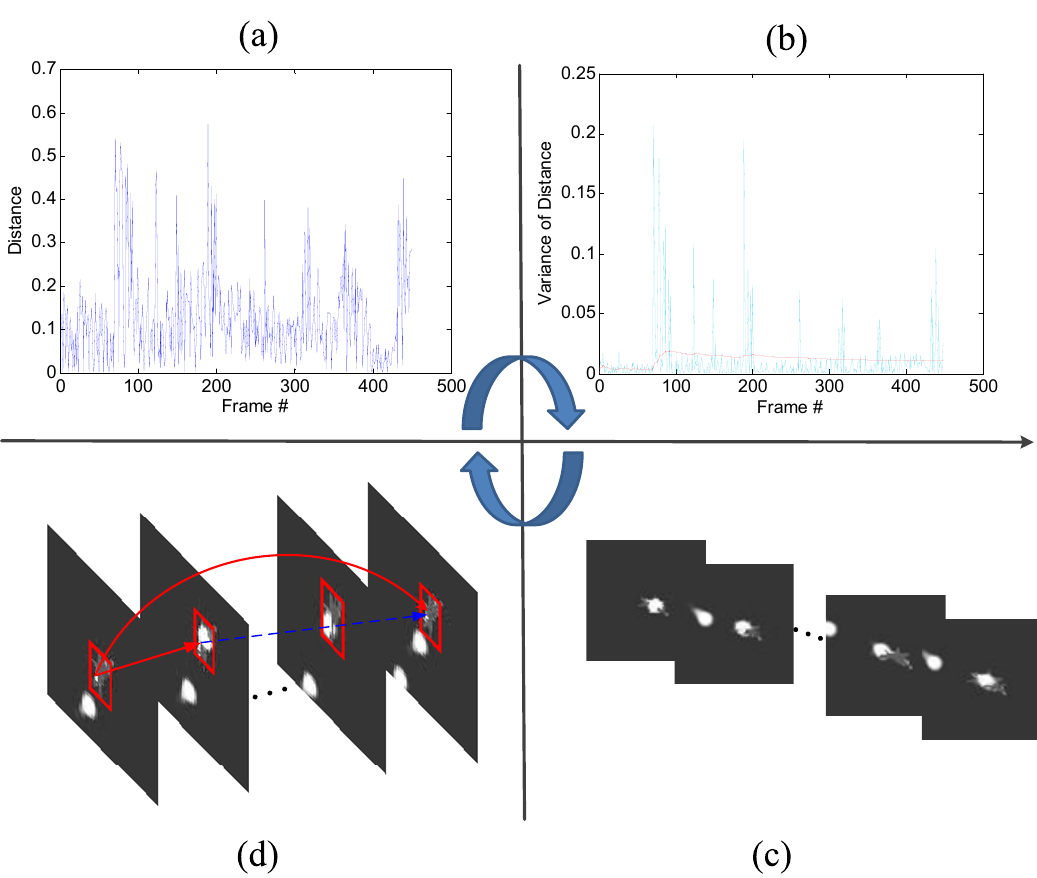
Figure 10. Schematic diagram for occlusion detection. ( a ) distance curve between selected region and target model in the model-matching process; ( b ) red plot represents the statistical variance information of historical frames, and light-blue plot represents the distance bias of the current frame; ( c ) frames that suffer from occlusion corresponding to the peak values in the light-blue plot; ( d ) update process of the